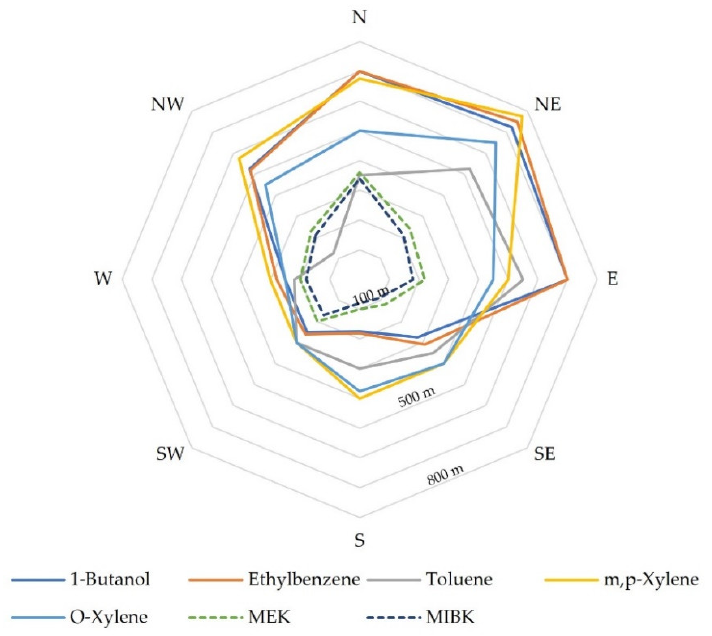
Figure 5. Distribution patterns according to wind direction classified by odor-potential substances.